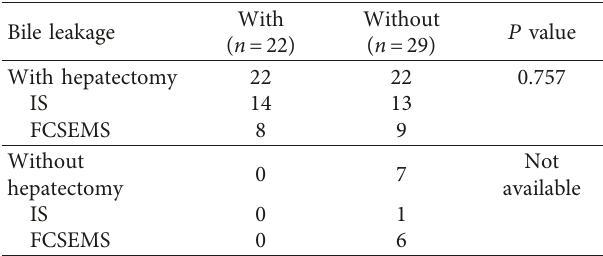
Table 4: Postoperative complications of bile leakage classified with and without hepatectomy and pancreatectomy.